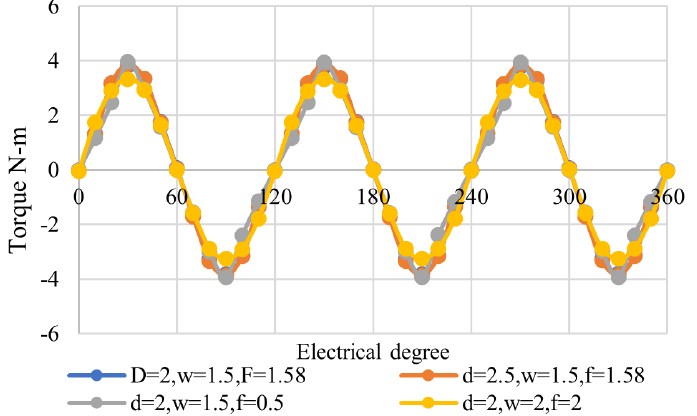
Figure 21. Results of hybrid (notch and